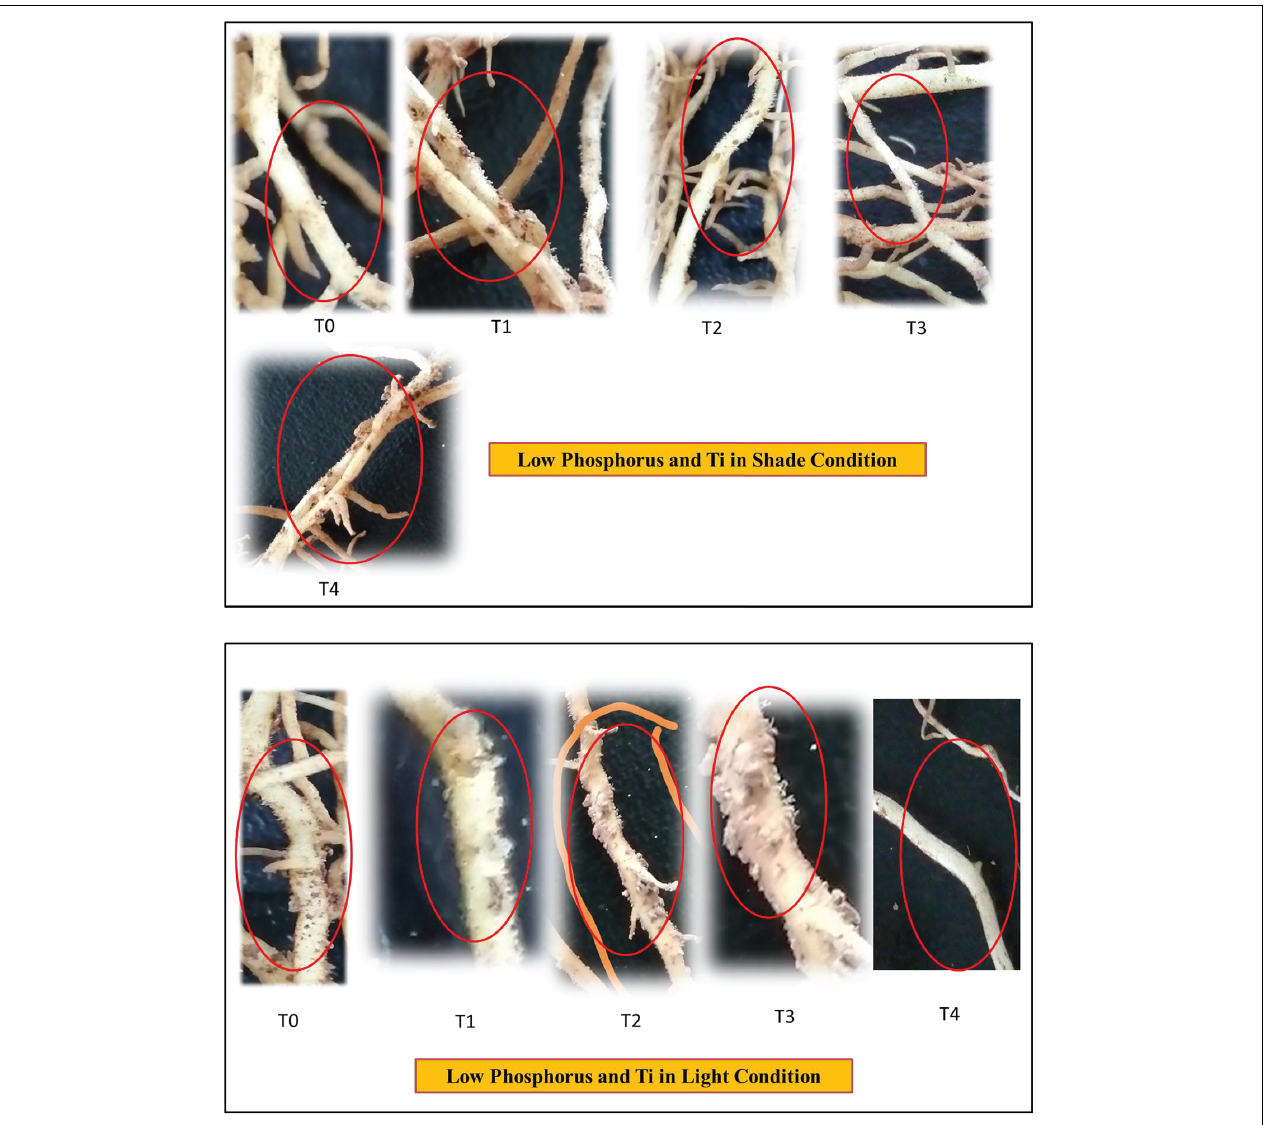
FIGURE 11 | Effect of Ti on root hair of soybean under NL and SC combined with LP conditions.